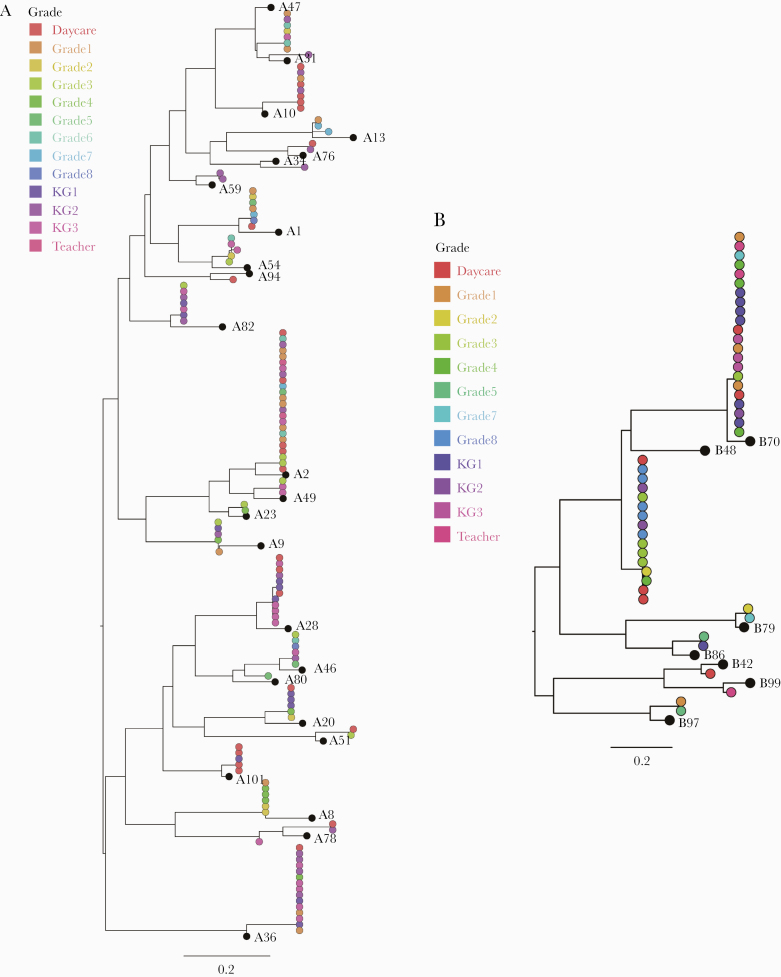
Phylogenetic analysis and genotype assignment of generated HRV sequences. Species-specific maximum likelihood trees of (A) HRV-A, (B) HRV-B, and (C) HRV-C. The tip shapes are colored by the school class of the individual. The scale bars represent nucleotide substitutions per site. The black tips represent the prototype sequence of respective strain. D, A circular bar plot showing the frequencies of HRV genotypes identified. The bars are colored by HRV species and the tips are labeled by HRV type and frequency. Abbreviation: HRV, human rhinovirus.